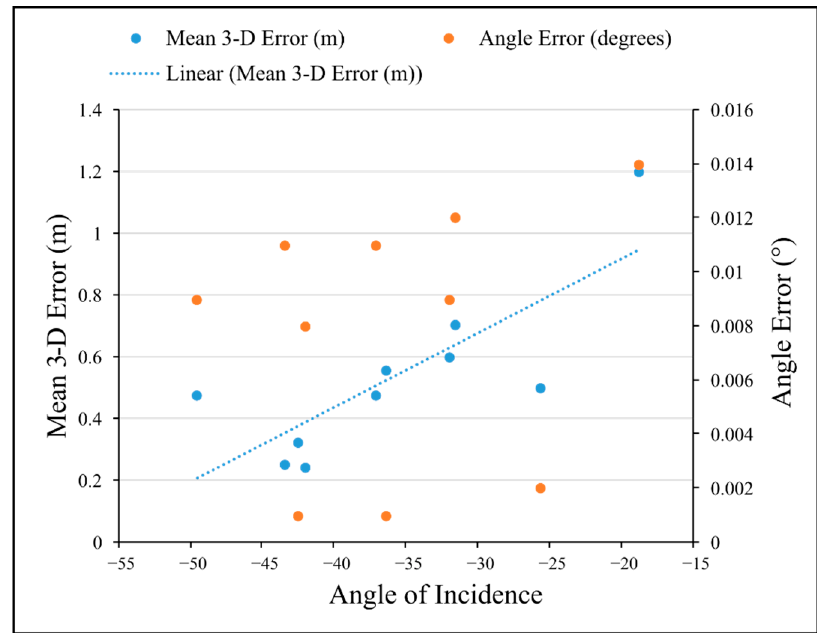
Figure 8. Relationship between angle of incidence and mean 3D error, and angle error in 10 wildfire images.